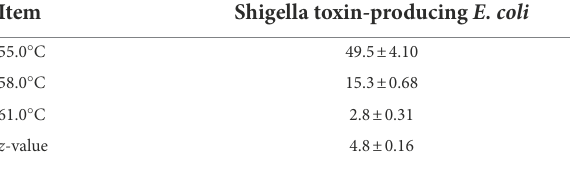
TABLE 3 Mean (± SE; n = 3) D -values (min) and z -values ( ° C) of STEC.